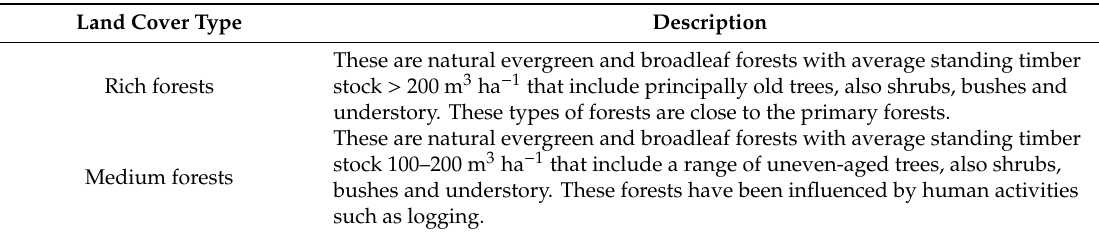
Table 1. Land cover types in the study area.